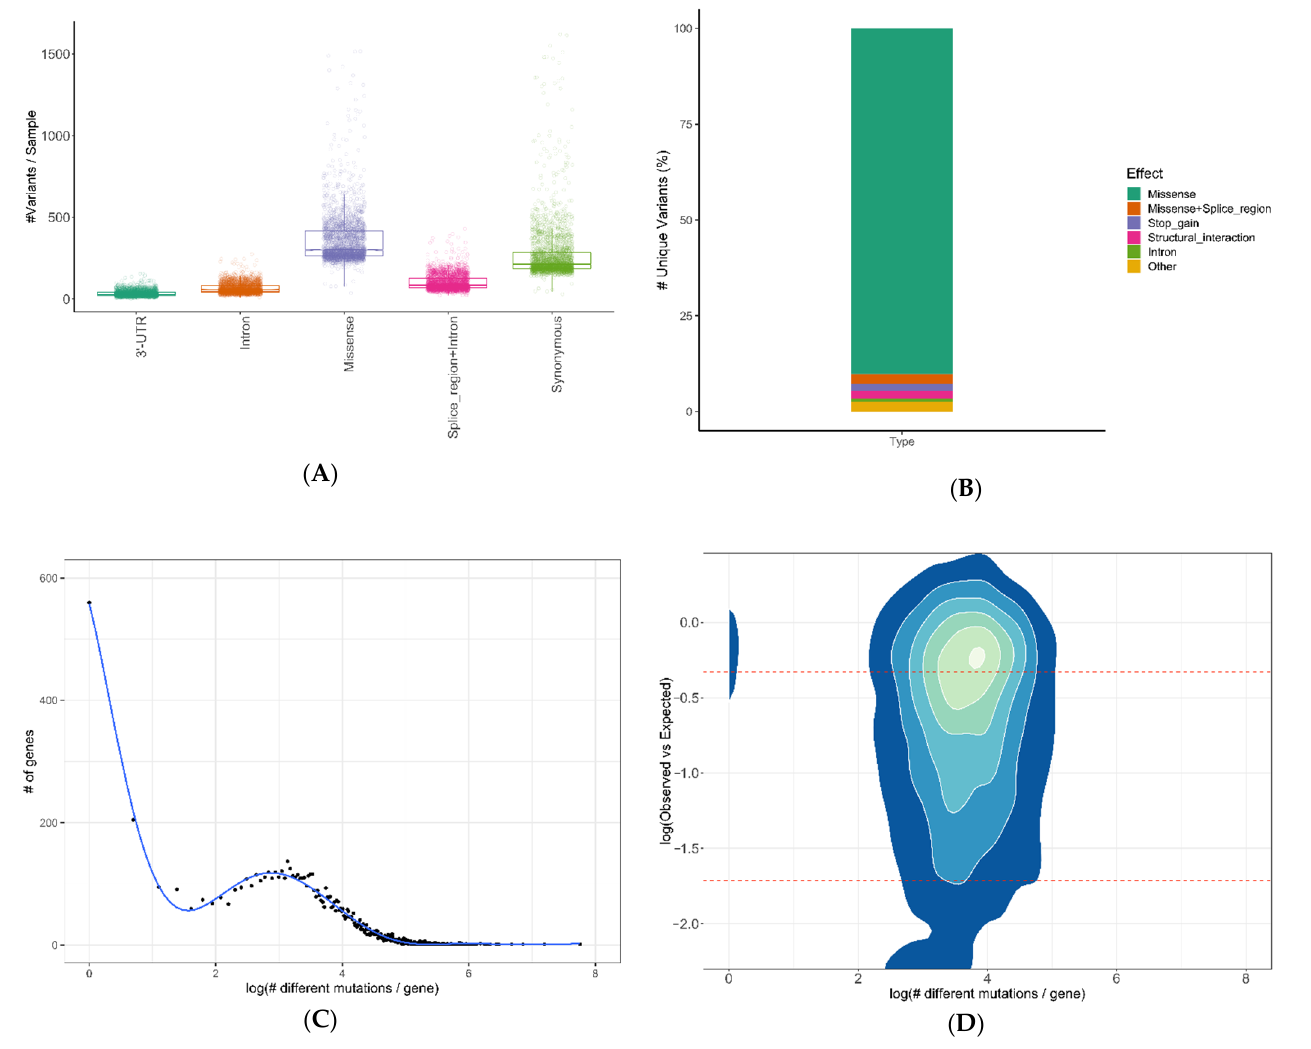
Figure 3. Genomic variability: ( A ) Number of variants detected per sample, classified by the five most abundant mutation classes. ( B ) Percentage of unique mutations detected in all 2474 patients, by class. ( C ) Genes sorted by the number of unique mutations detected (log-scaled). ( D ) Density map of gene constraints determined by gnomAD by the number of unique mutations detected (log-scaled). The red lines represent the first and forth quartiles for C and D. 3 (cid:48) UTR (variant in 3 (cid:48) untranslated Region); intron (variant in non-coding region); missense (non-synonymous variant in coding region); splice_region + intron (splice-site variant in non-coding region); synonymous (variant in coding region that produces the same amino acid); stop-gain (variant that causes a stop codon); structural interaction (interaction loci that are likely to be supporting the protein